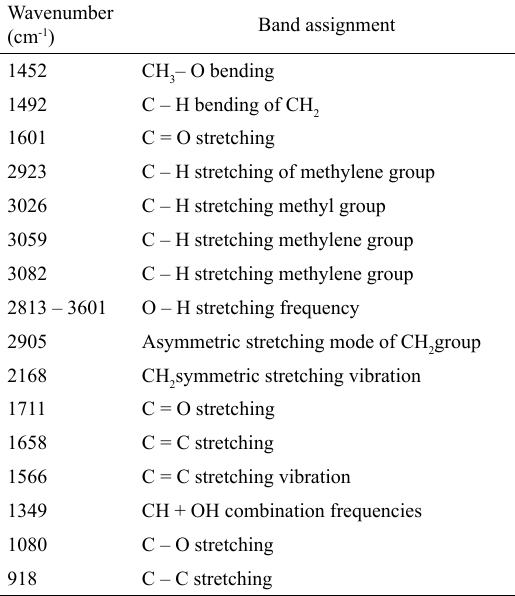
Table 1. FTIR peak assignment of pure and PVA/MAA:EA blend films. Wavenumber (cm -1 )